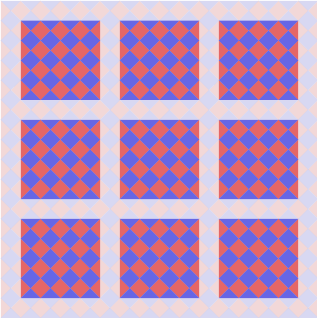
FIG. 11. Schematic diagram of nine logical qubits for d = 5 surface code. The vertices of the blue and red squares correspond to physical qubits. Each boldly colored patch consisting of blue and red squares represents a single logical qubit. In each logical qubit, the bold red (blue) squares represent a Pauli- Z (Pauli- X ) stabilizer operator acting on their